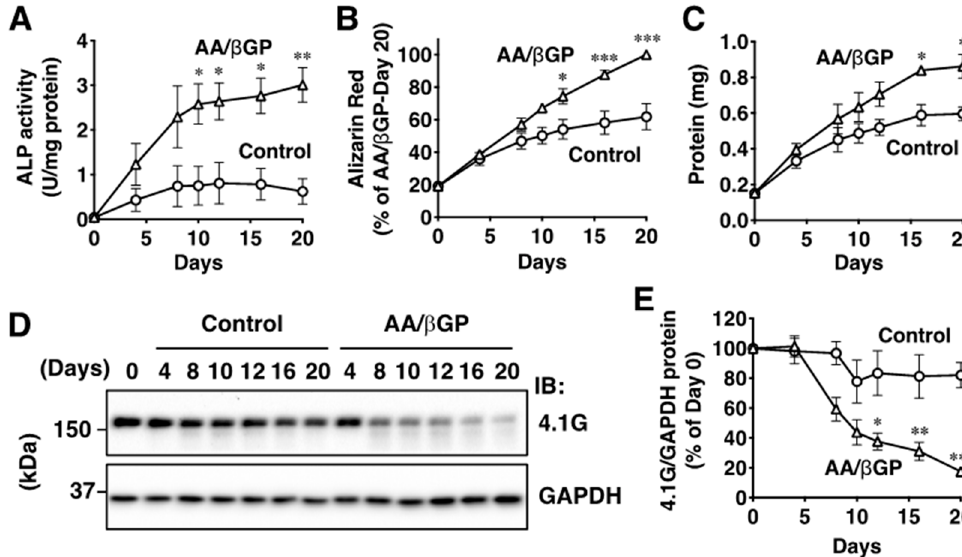
Figure 2. Protein expression levels of 4.1G decrease during the differentiation of MC3T3-E1 cells. The confluent MC3T3-E1 cells were treated with (triangle) or without (circle) 250 µ M ascorbic acid and 50 µ M β -glycerol phosphate (AA/ β GP) for up to 20 days. ( A ) Alkaline phosphatase (ALP) activity in the whole cell lysates was measured at the indicated time points. The activity was normalized by the protein content. ( B ) Calcium deposit on the cell surface was quantified by Alizarin red staining. The intensity of calcium deposit on the AA/ β GP-treated cells of day 20 was considered as 100%. ( C ) Protein content in the whole cell lysate was measured at the indicated time points. ( D ) Protein expression levels of 4.1G were analyzed by Western blotting. Whole cell lysates were immunoblotted (IB) with the anti-4.1G or anti-GAPDH antibody. One of four independent representative immunoblots is shown. ( E ) Relative 4.1G expression levels of ( D ). The amount of 4.1G protein expression at day 0 was considered as 100%. Data are presented as the mean ± standard error of the mean (S.E.M.) from 3 ( A – C ) and 4 ( E ) independent experiments. * p < 0.05, ** p < 0.01, *** p < 0.001, two-way analysis of variance (ANOVA) followed by Bonferroni’s test (vs. Control of each